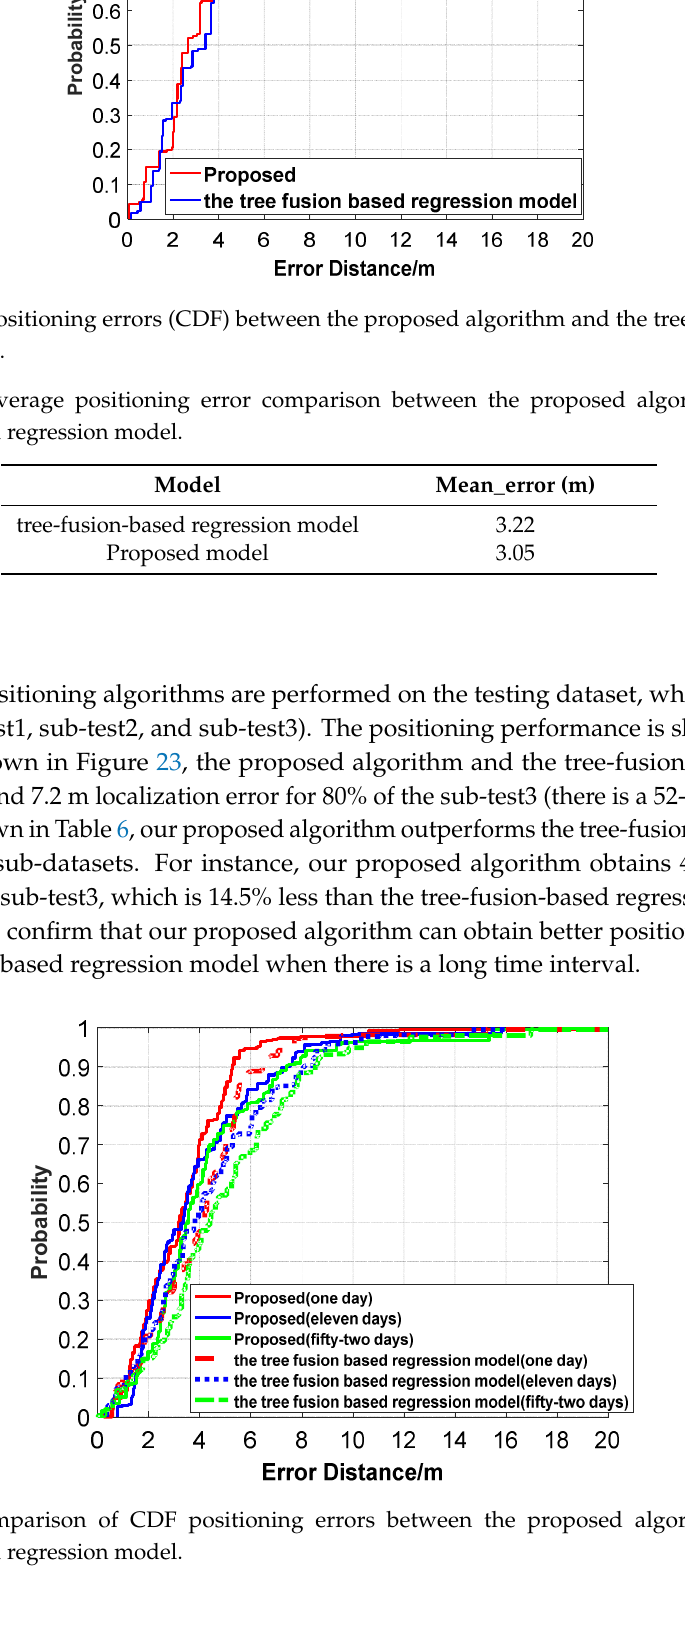
fusion-based regression model.